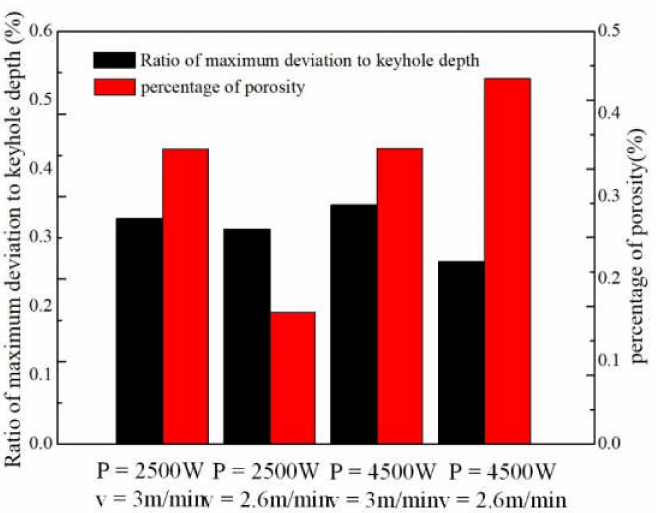
Figure 12. Effect of process parameters on ratio of maximum deviation to keyhole depth and percentage of